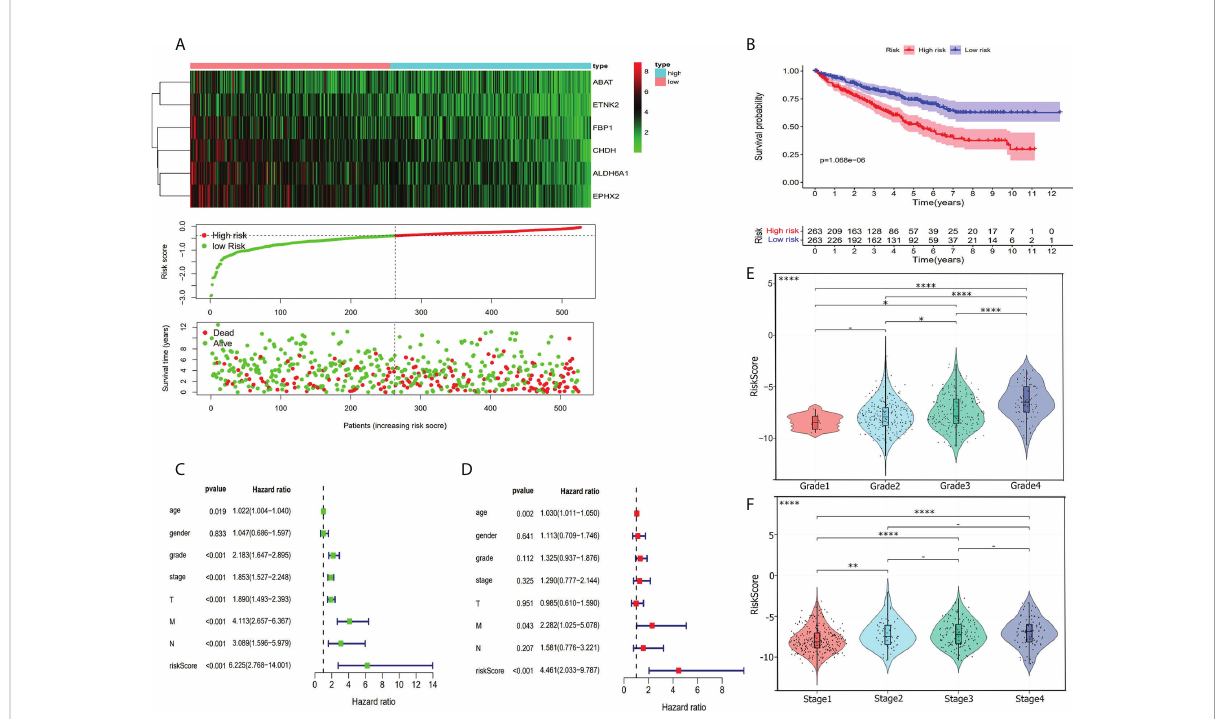
FIGURE 7 Risk score evaluation. (A) To evaluate the prognostic model, we compared the expression of six hub genes in high-risk patients and low-risk patients. Heatmap shows the condition of six hub genes expression. Risk score cove and patients ’ survival time plot show the relationship between risks core and patients ’ survival time. (B) Kaplan-Meier survival curves for high-risk and low-risk patients. (C) Forrest plot of the univariate Cox proportional regression analysis in TCGA-KIRC cohort. (D) Forrest plot of the multivariate Cox regression analysis in TCGA-KIRC cohort. (E) Violin plot shows risk score was closely associated with ccRCC grade. (F) Risk score has a relationship with the ccRCC stage. *, P < 0.05; **, P< 0.01; ****, P<